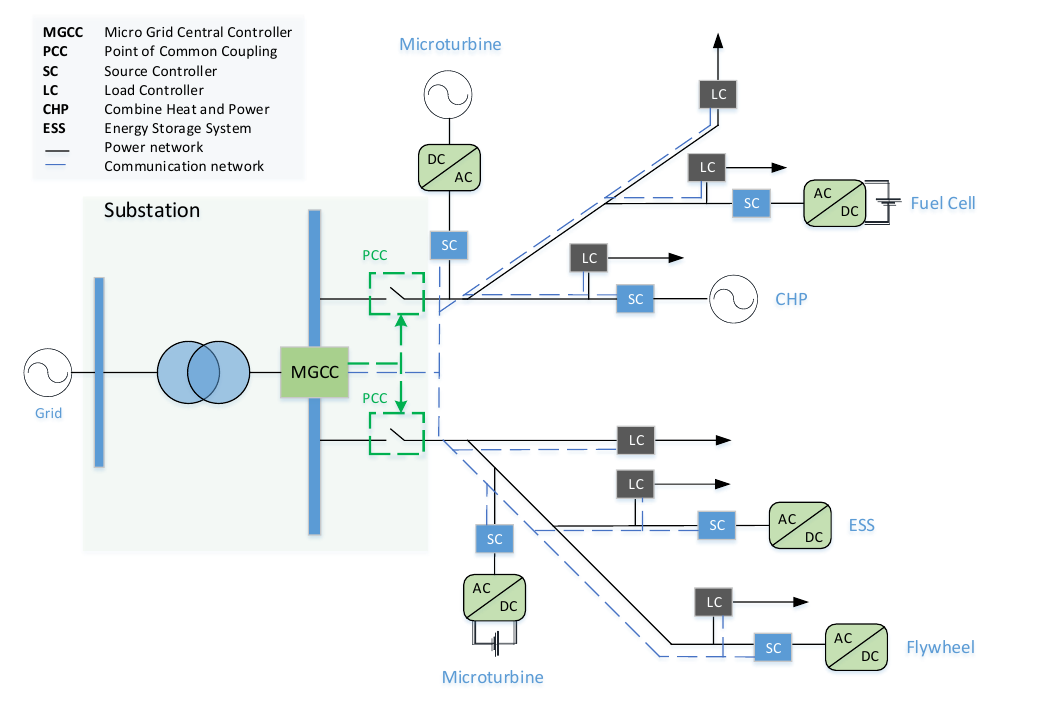
Figure 6. Optimal control strategy in a power smart substation SPSS.